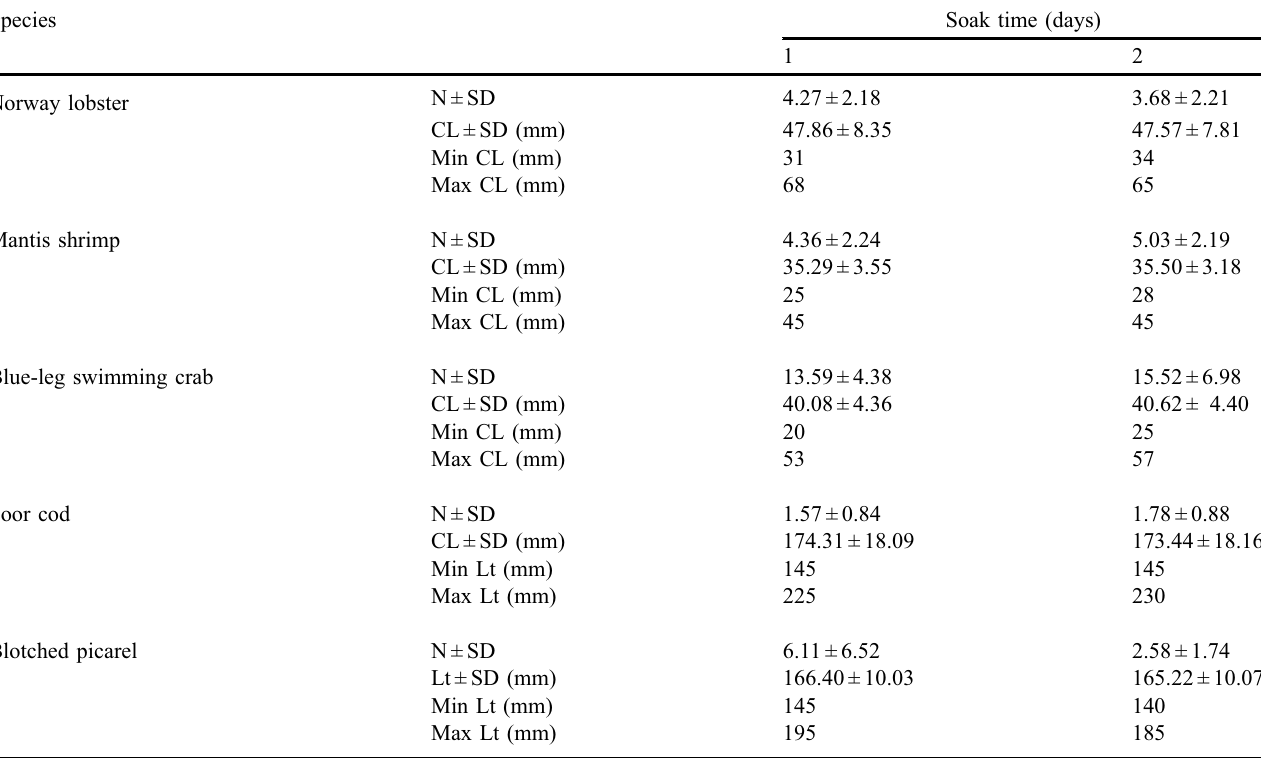
Table 1. Catch summary table; N: average number of individuals caught per each creel longline; CL: carapace length; Lt: total length; Lt stuck: average length of individuals stuck in the creel meshes; SD: standard